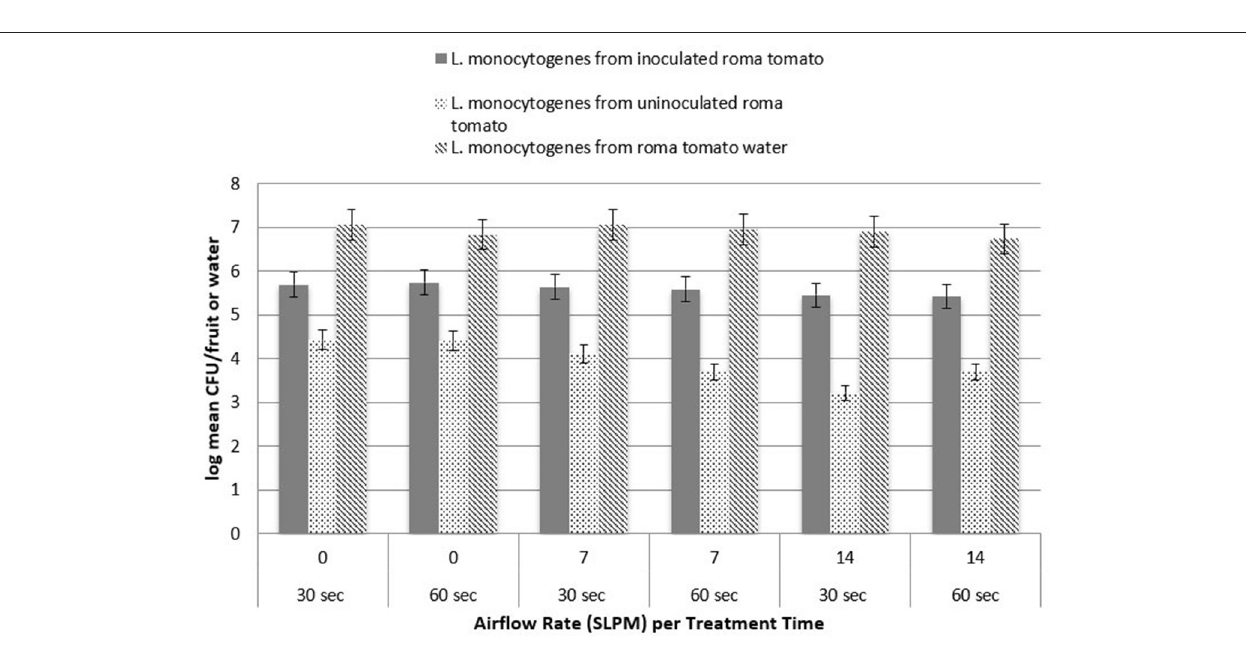
FIGURE 5 | Recovery of L. monocytogenes from inoculated and uninoculated Roma tomatoes, as a function of treatment time ( n =